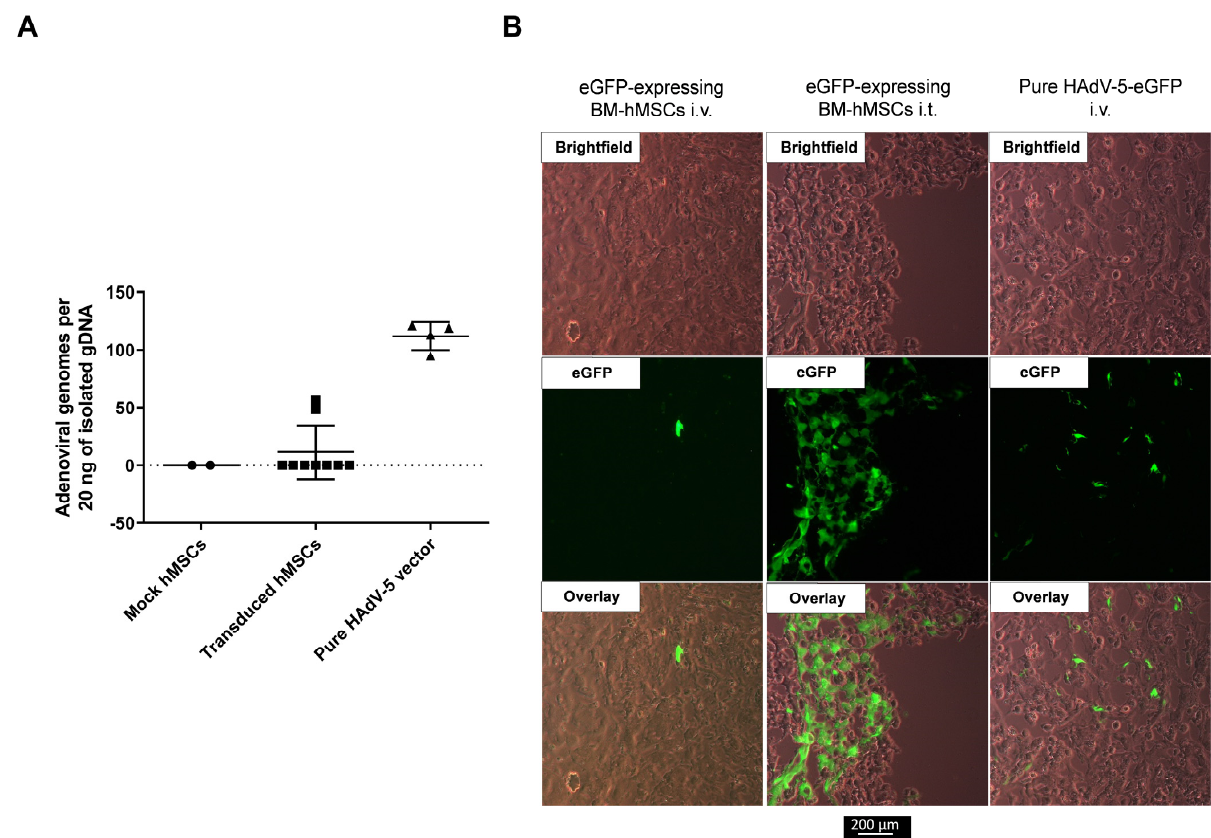
Figure 8. No infiltration of i.v. ‐ injected hMSCs in UM ‐ SCC ‐ 11B tumors in the CAM model. UM ‐ SCC ‐ 11B xenograft tumor ‐ bearing fertilized chicken eggs were injected either i.v. or i.t. with 5 × 10 5 of either non ‐ transduced hMSCs (mock) or hMSCs having been transduced with eGFP ‐ expressing replication ‐ incompetent HAdV ‐ 5 ‐ HexPos3 vectors 3 h prior to injection. Additionally, eggs were injected i.v. with 5 × 10 9 pure eGFP ‐ expressing replication ‐ incompetent HAdV ‐ 5 vector particles. Injections were performed on day 4 after tumor cell application on the CAM. Tumors were isolated from the CAM 48 h post ‐ vector/hMSCs injections and snap ‐ frozen in liquid nitrogen. ( A ) Total DNA was isolated, and the copy number of the adenoviral E4 gene was analyzed by qPCR. Since hMSCs were transduced with a replication ‐ incompetent first ‐ generation HAdV ‐ 5 vector (expressing eGFP) before injection, the presence of adenoviral E4 in the isolated total tumor DNA can be considered an indicator for hMSC infiltration. Results of the qPCR analysis are shown as mean ± standard deviation (mock n = 2, transduced hMSCs n = 9, pure HAdV ‐ 5 n = 4). ( B ) Representative images of tumor sections analyzed by fluorescence microscopy. 4. Discussion Using hMSCs as carrier cells for oncolytic adenoviral vectors (oAVs) holds promise to enable systemic delivery and expands therapeutic options for the treatment of a range of cancer entities, including head and neck squamous cell carcinomas (HNSCCs). In this study, we investigated whether the recently published Hexon ‐ modified vector HAdV ‐ 5 ‐ HexPos3 can serve as a tool for hMSC ‐ based oncolytic therapy [29]. Moreover, we analyzed hMSC migration toward HNSCC xenografts in vivo and in ovo. Investigation of different replication ‐ competent HAdV ‐ 5 ‐ HexPos3 vectors revealed that increased infection efficiency of Hexon ‐ modified particles led to efficient virus replication in hMSCs. Moreover, mature viral progeny are released and can re ‐ infect HNSCC cell lines in vitro. This holds not only true for life cycle ‐ unmodified HAdV ‐ 5 ‐ HexPos3 but also for the life cycle ‐ modified conditionally replicating vectors HAdV ‐ 5 ‐